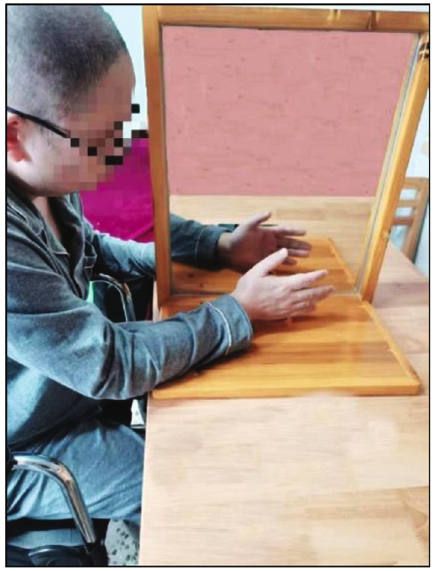
Figure 1: Mirror